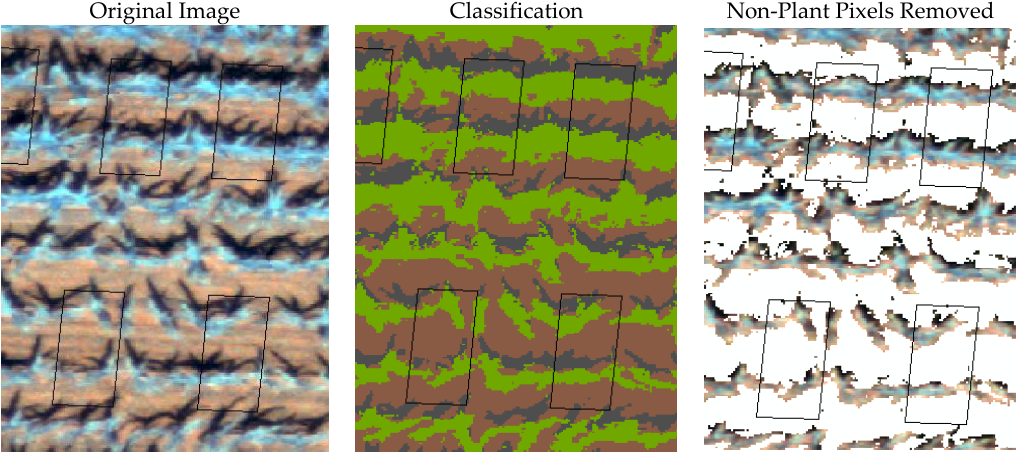
Figure 1. Example of an original image ( left ), the classification ( center ) with green representing plant tissue, brown representing illuminated soil, and black representing shaded soil. The third image ( right ) shows original image after removal of soil pixels. Black rectangles delineate spots where plants were later sampled destructively for LAI and biomass measurements.